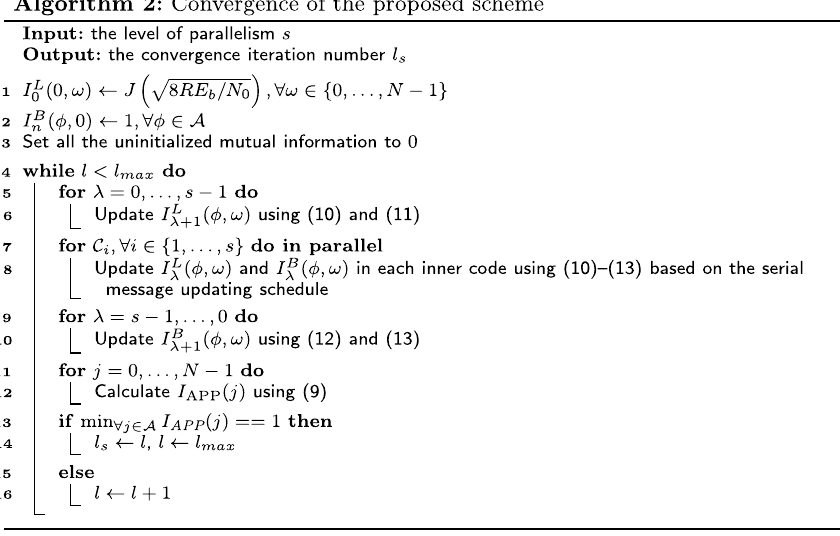
The process of tracking the minimum I APP ( j ) is described in Algorithm 2. The process of Algorithm 2 is very similar to Algorithm 1. First, initialize each parameter in lines 1 to 3. Update input mutual information of the decoders for outer codes, I Algorithm 2. The decoding of outer codes is performed in lines 7 and 8 in parallel. The output mutual information of the outer code is updated in lines 9 and 10. Then, calculate I APP ( j ) using (1). If the value of I APP ( j ) is 1 for all j s, then it is considered the time when the decoding ends and the number l is set as the convergence iteration number l s . We can obtain l s which is the number of iteration when the proposed scheme with s